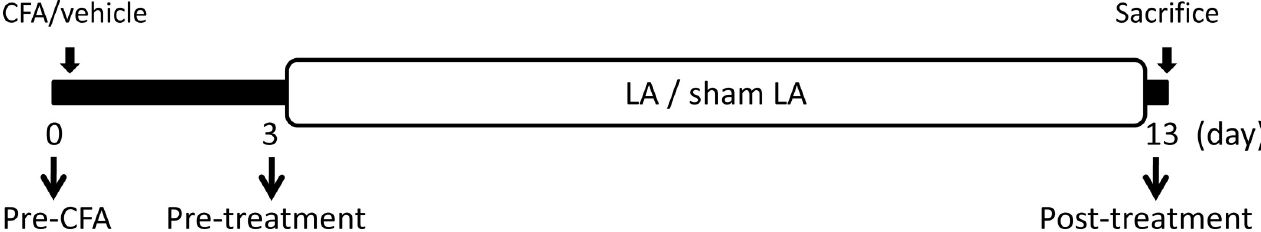
Fig 1. Experimental design. Complete Freund’s adjuvant (CFA) or vehicle was intraarticularly injected at Day 0. Pain withdrawal threshold and swelling assessments were examined at timepoints of Pre-CFA, Pre-treatment and Post-treatment. Three days after injection of CFA (Day 3), animals were treated with laser acupuncture (LA) and sham-operated LA (sLA). Following the 10-day treatment (Day 13), animals were sacrificed for histology and immunohistochemistry assays.